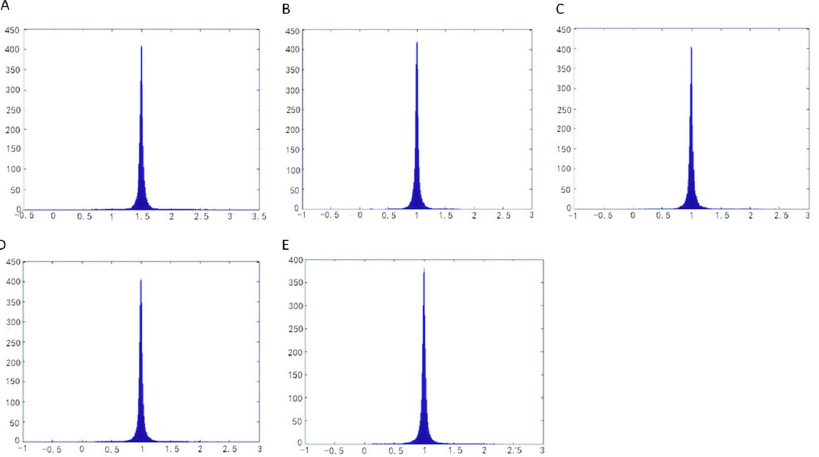
Fig 16. Histograms of angle distortions on the beetle model. (A) result by LABF, (B) result by LQHP, (C) result by IQCP, (D) result by QCTM,(E) result by our method.